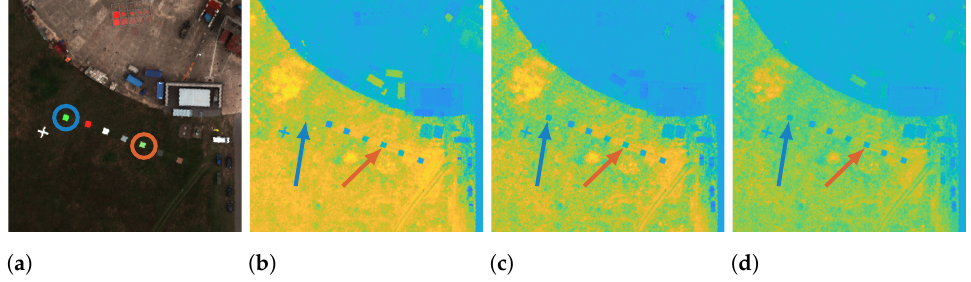
Figure 3. Optimal VI experiments ( a ) UDRC Test Image. ( b ) NDVI ratio. ( c ) NDVI re ratio. ( d ) RENDVI ratio. (In ( b – d ) warmer colours indicate higher levels of vegetation and colder colours indicate